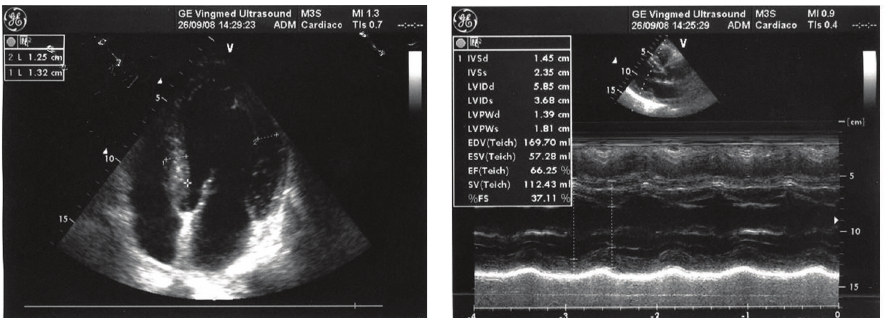
Figure 5: Case 2: echocardiography before the last bortezomib